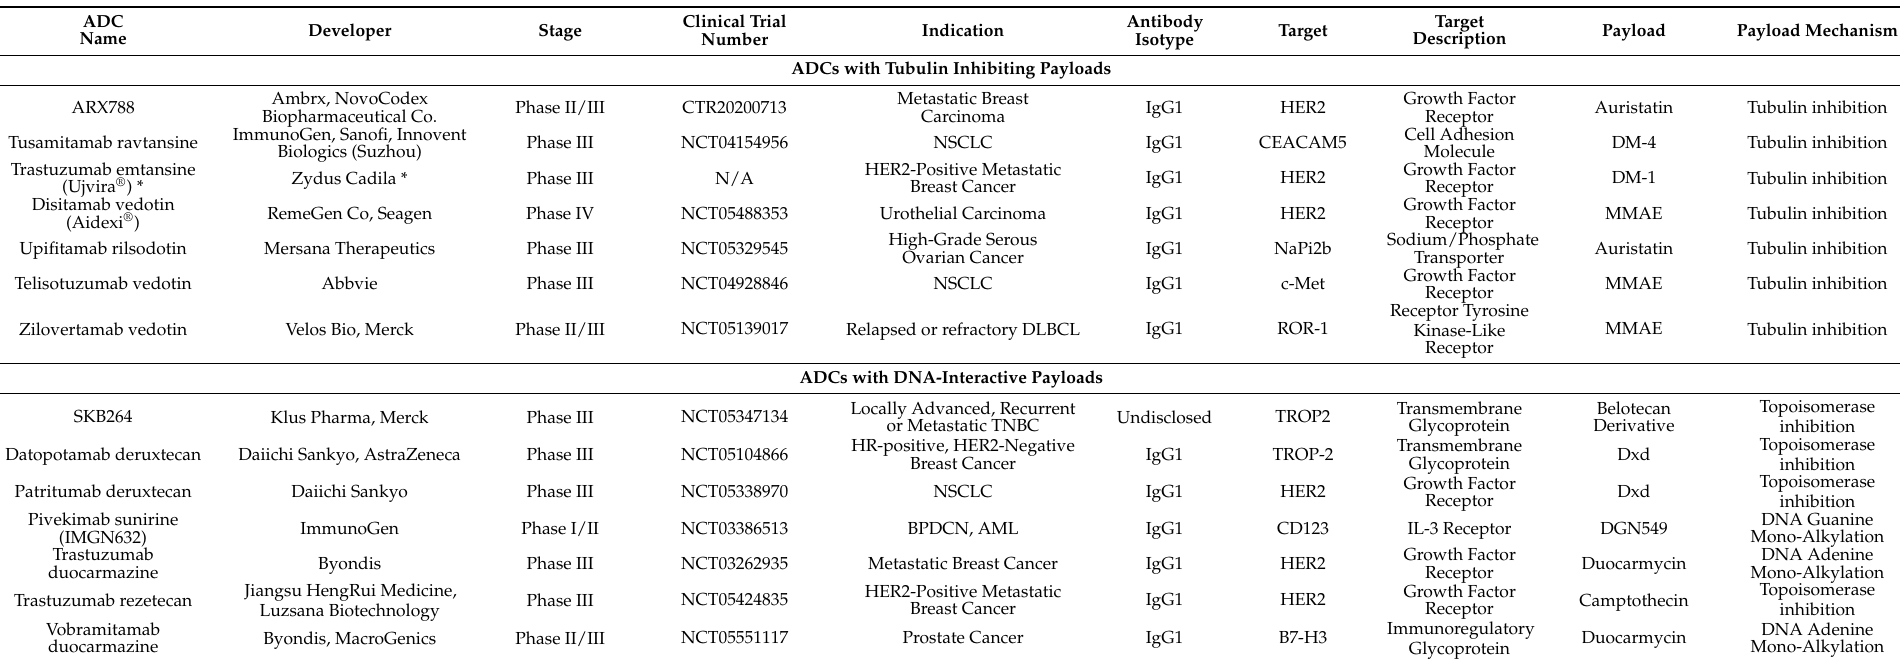
Table 2. Selected Novel ADCs in Late-Stage Clinical